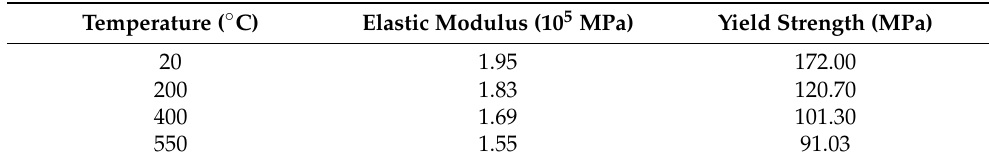
Table 2. The fracture toughness of 35CrMo.